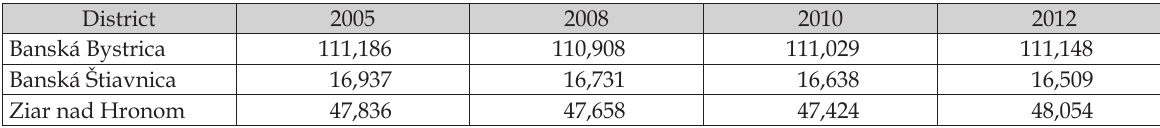
Table 3. Population in the research